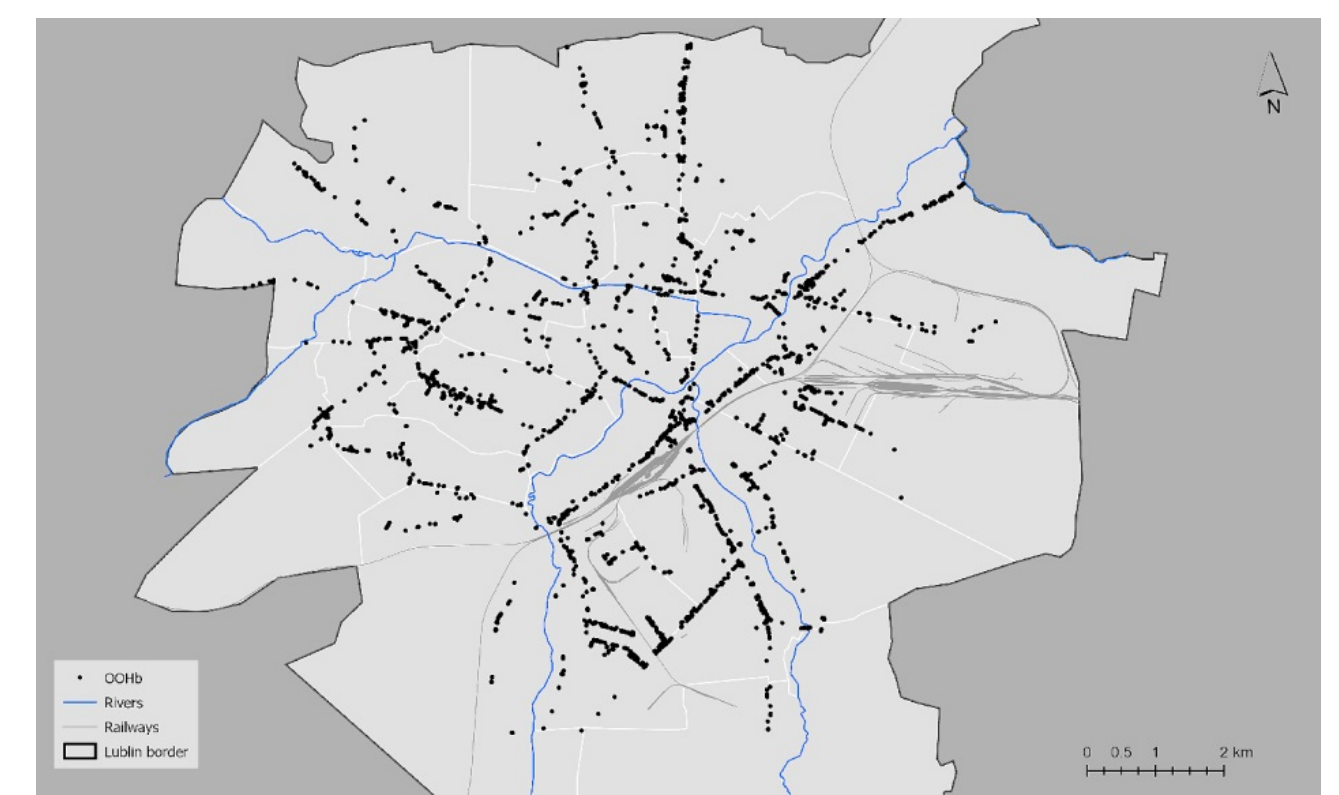
Figure 2. The out of home advertising media location in Lublin City, Poland: the insight into VP spatial extent (own elaboration based on field measurement campaign in 2015).